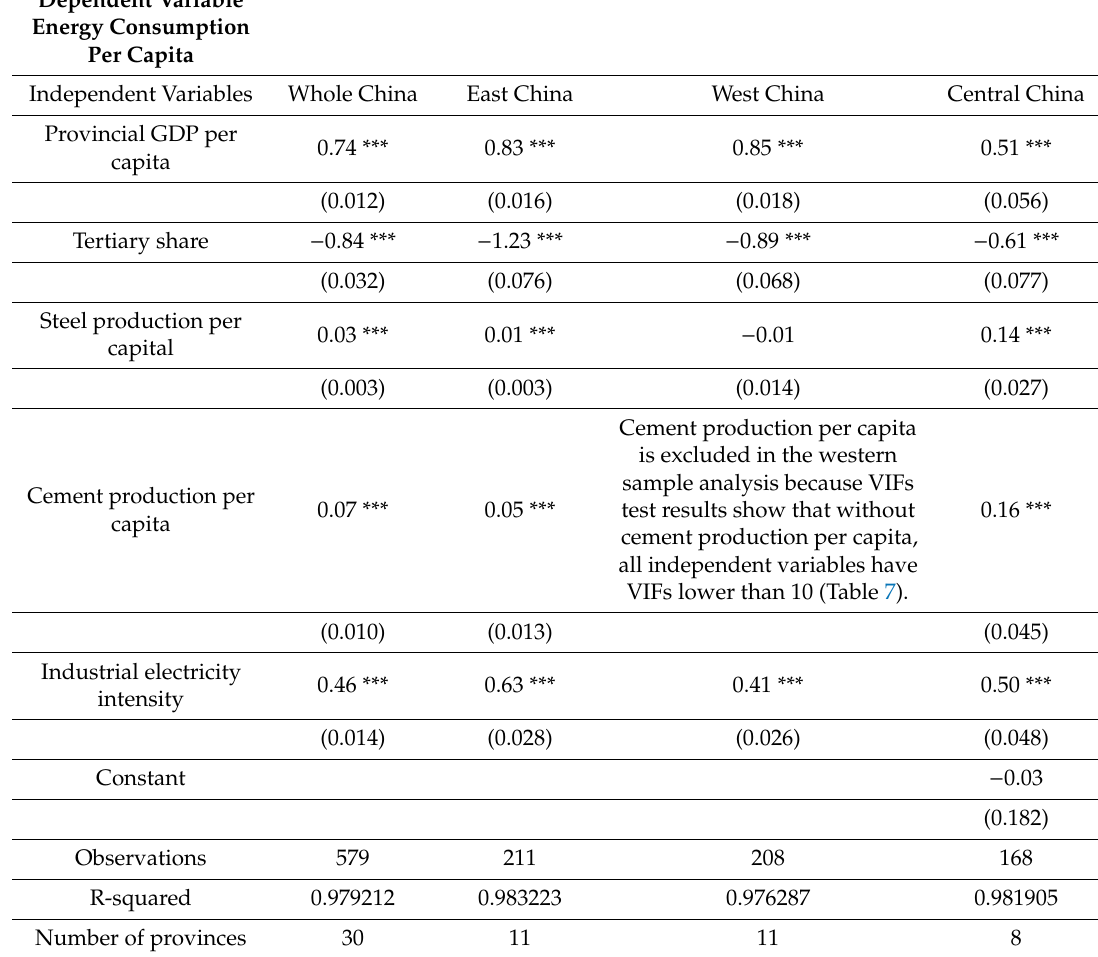
Table 6. Estimation